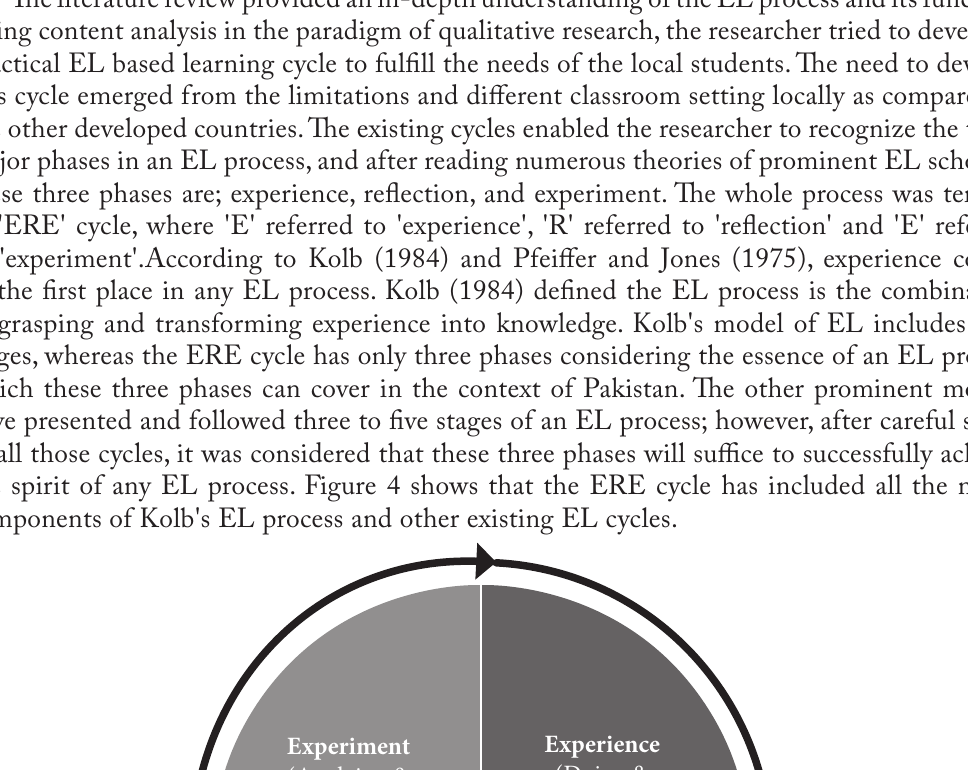
Experiment (Applying & Testing)